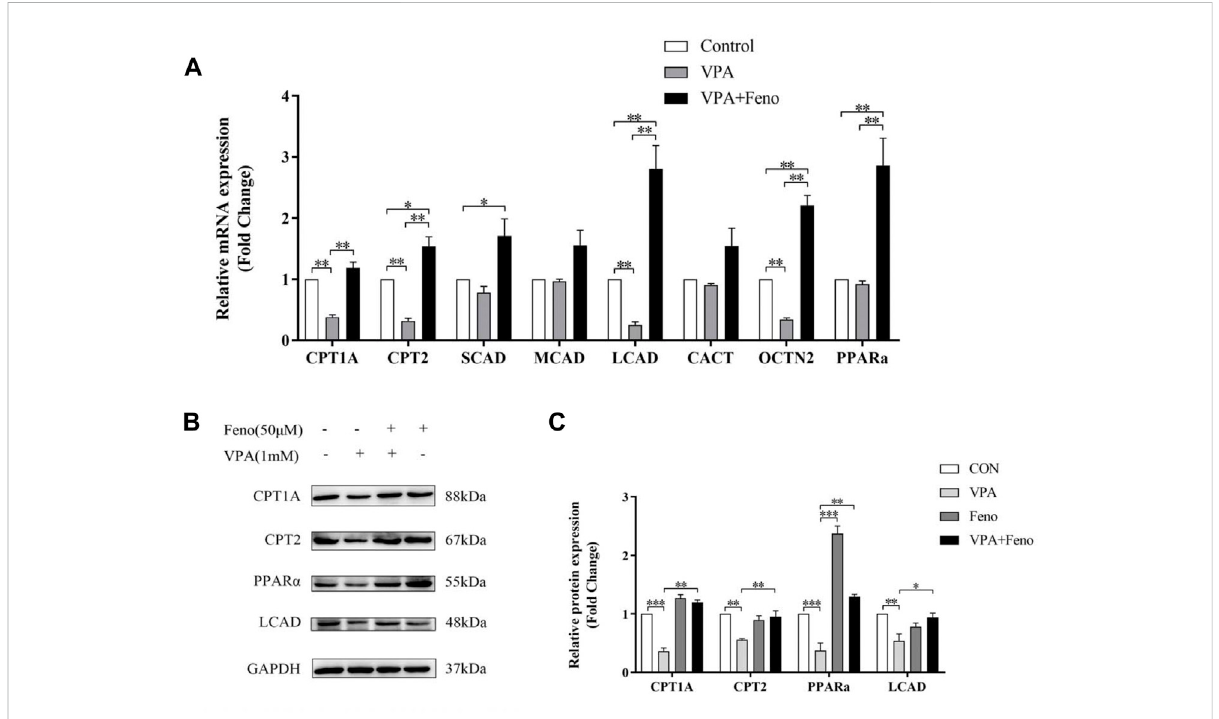
FIGURE 13 Effect of Feno on the expression of ACs-related genes. (A) Real-time PCR technique to detect the effect of VPA (1 mM) and Feno (50 μ M) on ACs-metabolism-related genes. (B – C) Western blot detection of the effect of VPA and Feno (50 μ M) on protein expression of ACs-metabolism- related genes. Data are expressed by mean ± SD ( n = 3). *p < 0.05 **p <